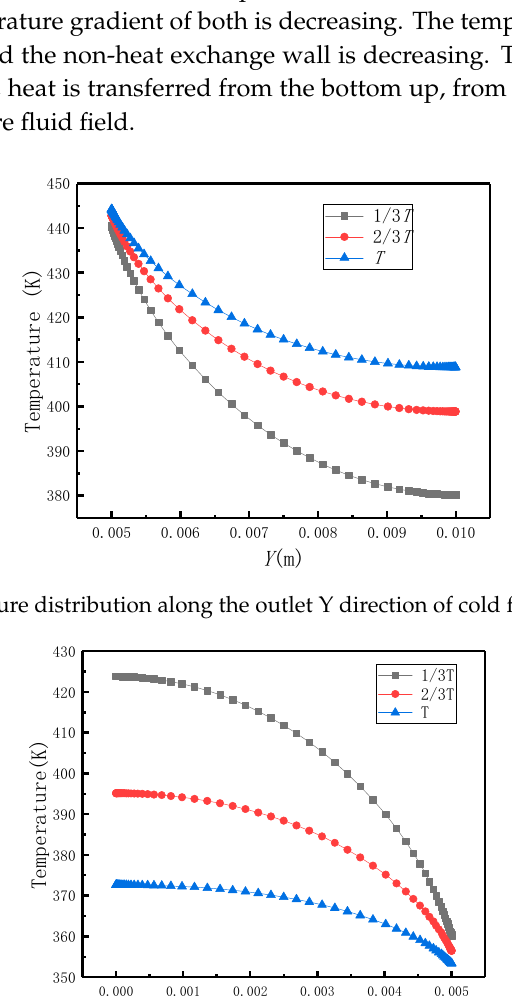
Figure 11. Temperature distribution along the outlet Y direction of thermal fluid at different time.